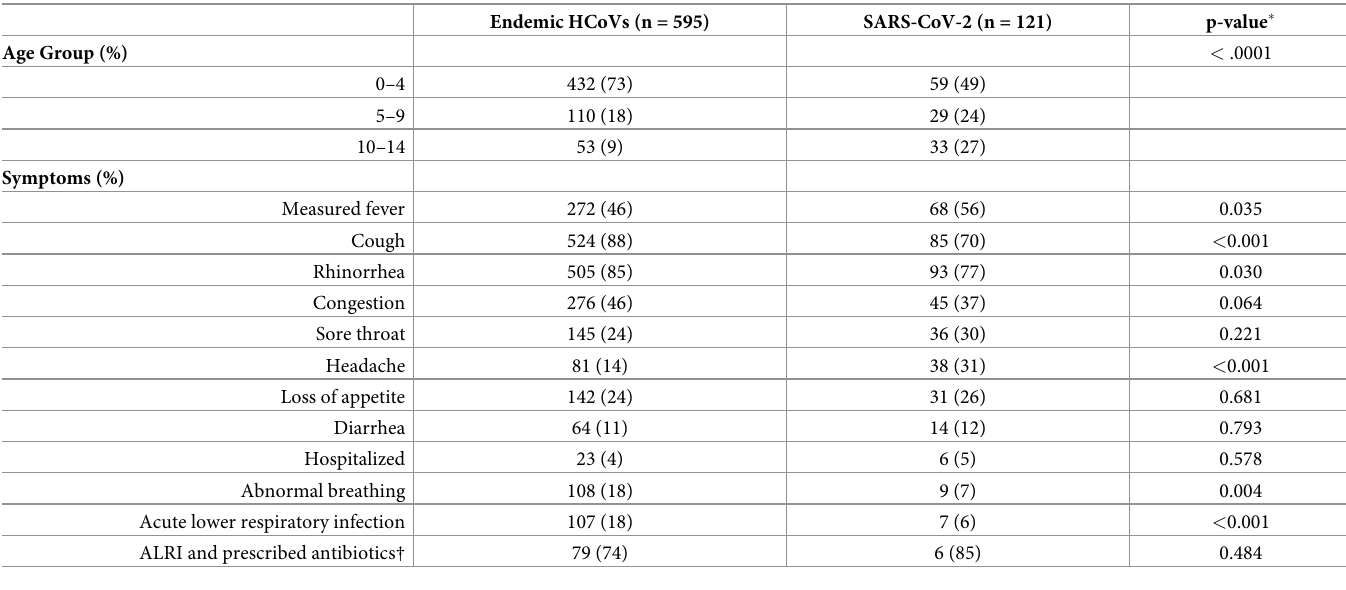
Table 2. Study participants and symptom